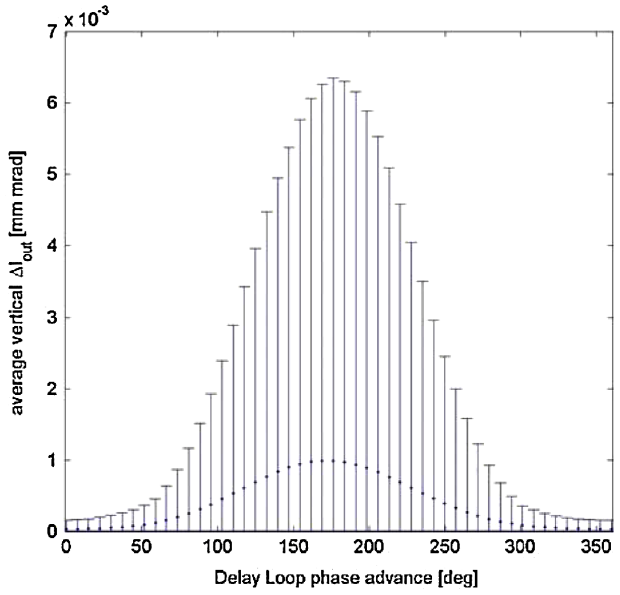
FIG. 24. Average rms vertical emittance with respect to the central slice of each bunch for a beam passing 1 mm off axis in the vertical plane as a function of the DL phase advance.